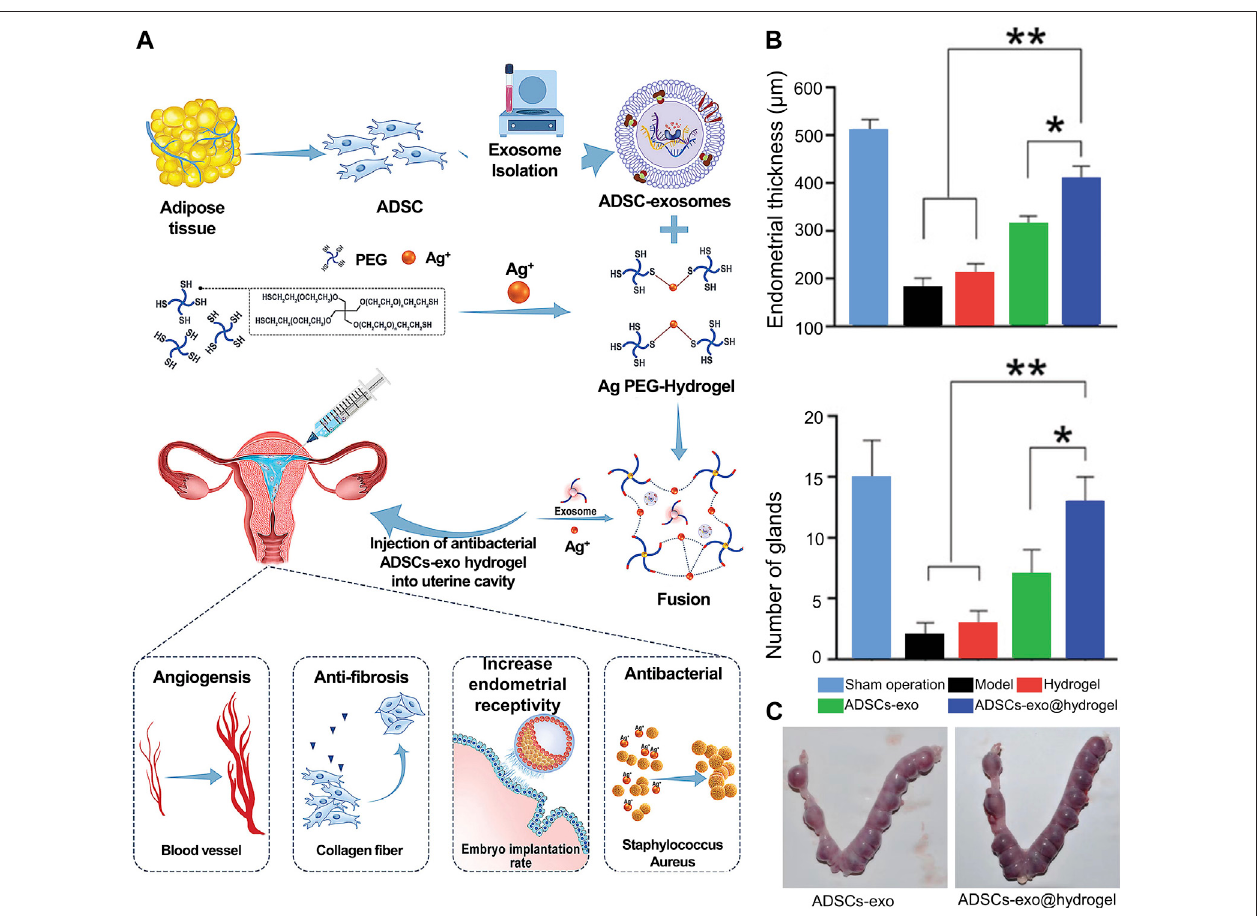
FIGURE 7 | Whole overview of ADSC-exosome-hydrogel. (A) Preparation procedures of ADSCs-exosome hydrogel. (B) Performance of ADSC-exosome- hydrogel in endometrial regeneration. (C) Performance of ADSC-exosome-hydrogel in endometrial receptivity. Reproduced with permission (Lin et al., 2021). Copyright 2021 WILEY-VCH Verlag GmbH & Co. KGaA,